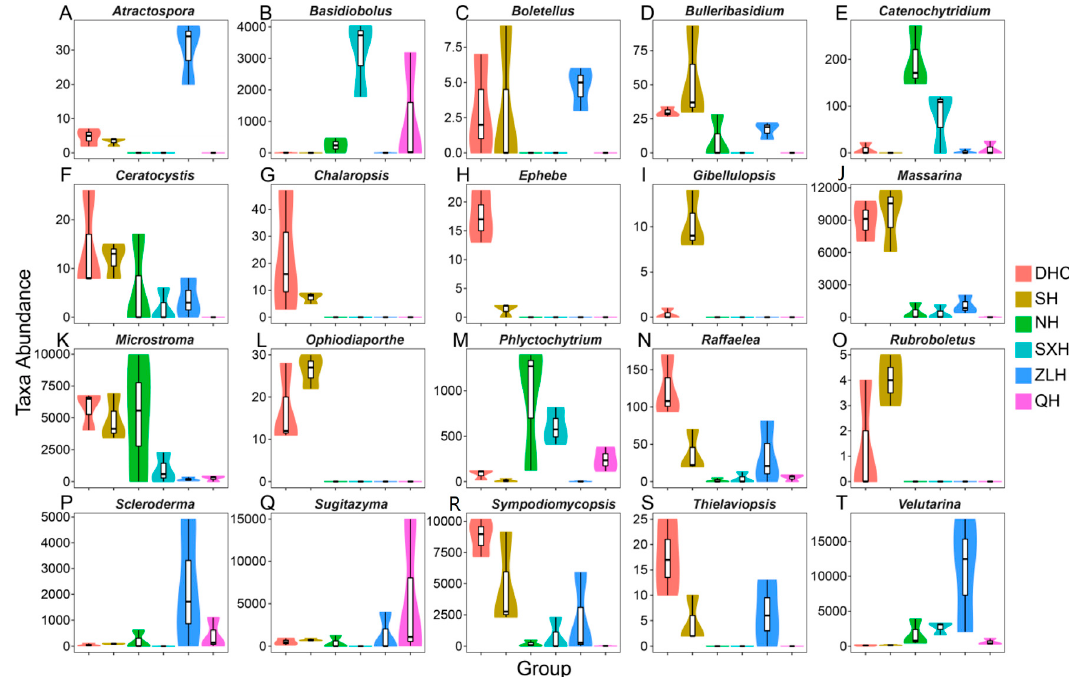
Figure 5. Fungal relative abundance of genera. Twenty genera were selected for their significant di ff erences among DHC, SH, NH, SXH ZLH and QH. Relative abundance of Atractospora ( A ), Basidiobolus